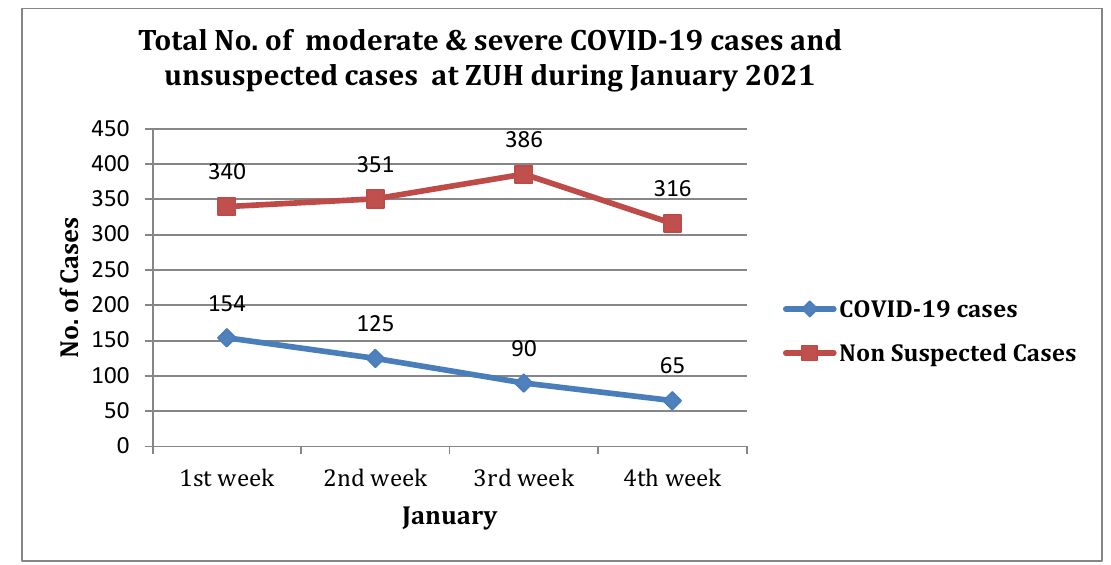
Figure 2. Total No. of moderate and severe COVID-19 cases in comparison to unsuspected cases at ZUH during February